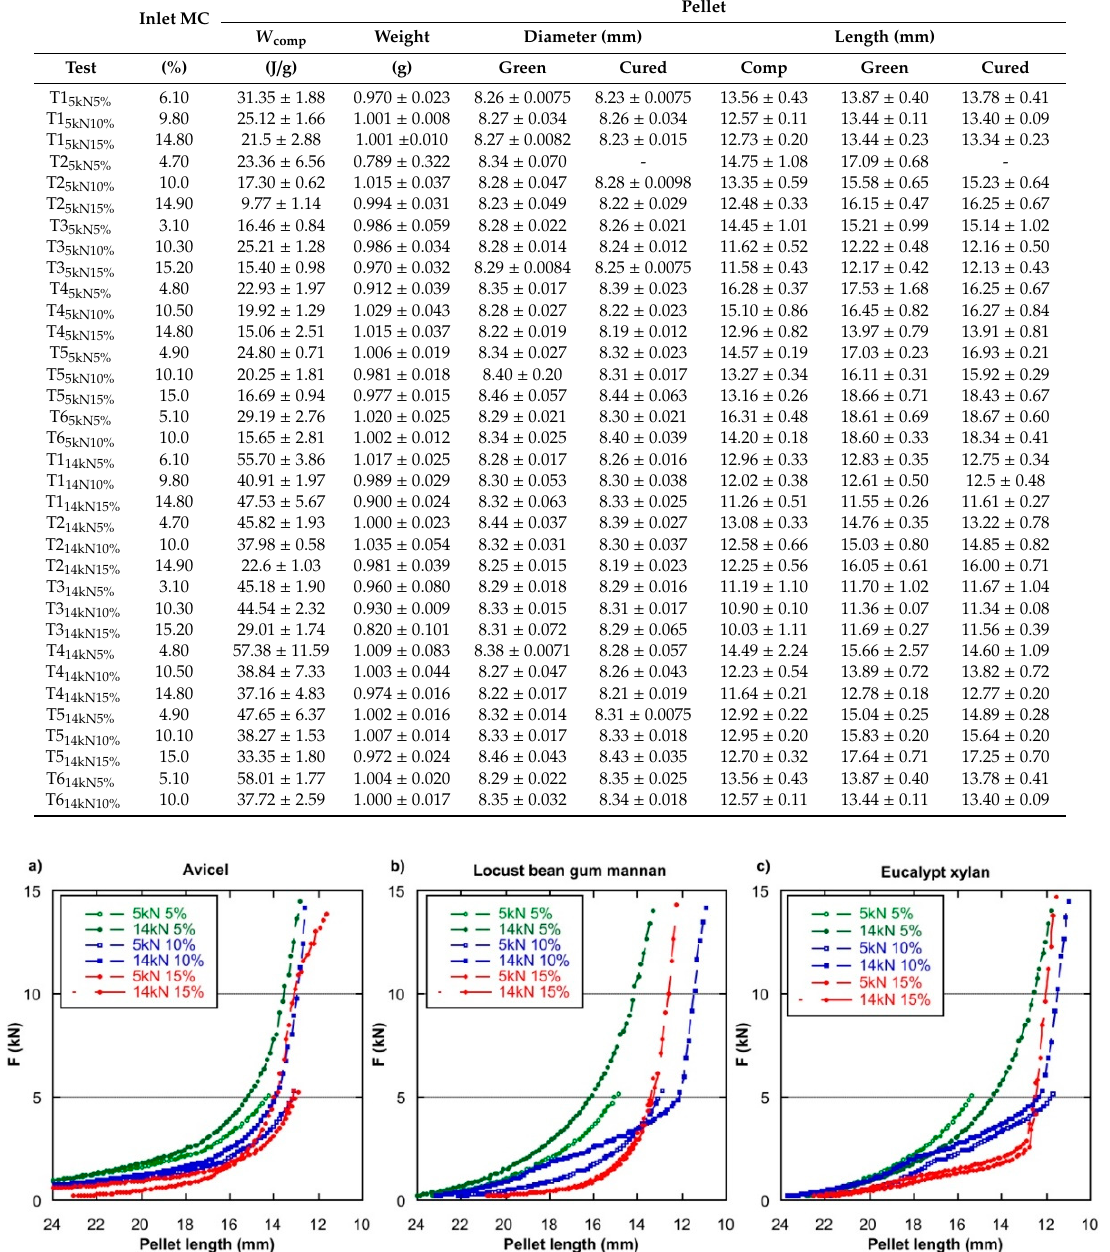
Table 3. Test results corresponding to moisture content, energy required for compression, pellet weight, pellet diameter, and pellet length for compressed, green pellets, and cured pellets.